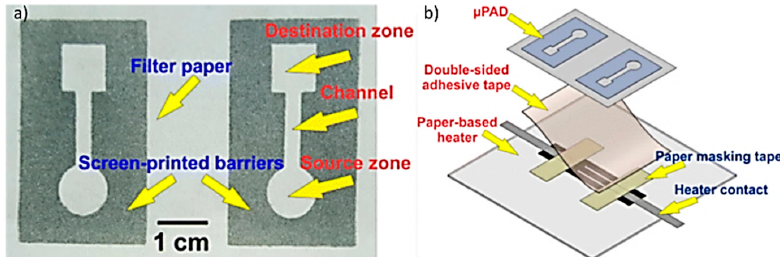
Figure 12. ( a ) Image of paper ‐ based μ PAD, which is fabricated by screen ‐ printing of crayon eye liner on filter paper. ( b ) Schematic shows the process of sticking the μ PAD to the paper ‐ based heater using a piece of double ‐ sided adhesive tape (Adapted with the permission of Springer Nature) [69].